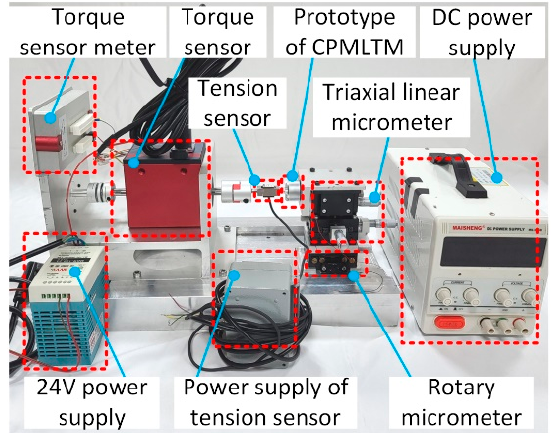
Figure 17. Prototype of CPMLTM.